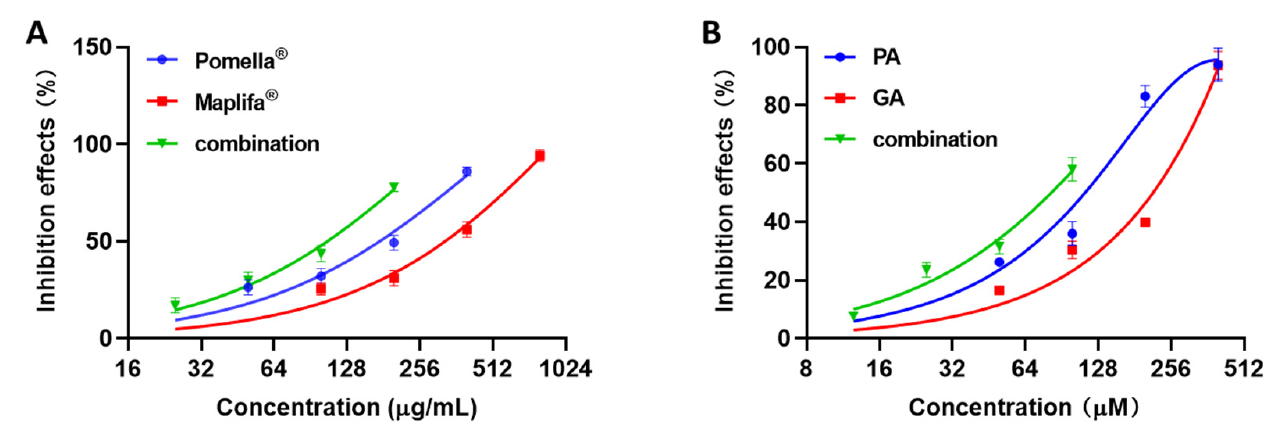
Figure 2. Synergistic inhibitory effects of the combinations of ( A ) Pomella ® + Maplifa ® (at a ratio of 1:2 combinations; 2.5 + 25, 25 + 50, 50 + 100, and 100 + 200 µg/mL; presented by the green lines) and ( B ) PA + GA (in a ratio of 1:1 combination; 12.5 + 12.5, 25 + 25, 50 + 50, and 100 + 100 µM; presented by the green lines), and their activity was compared to the activity of their individual sample (Pomella ® , presented by the blue line; Maplifa ® , presented by the red line; PA, presented by the blue line; and GA presented by the red line).